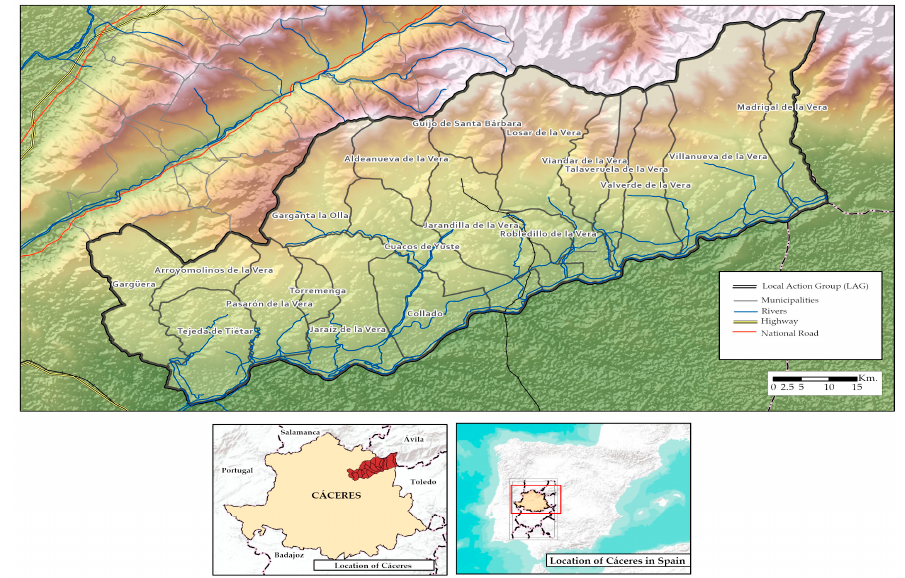
Figure 1. Location of La Vera region, Source: Own elaboration.